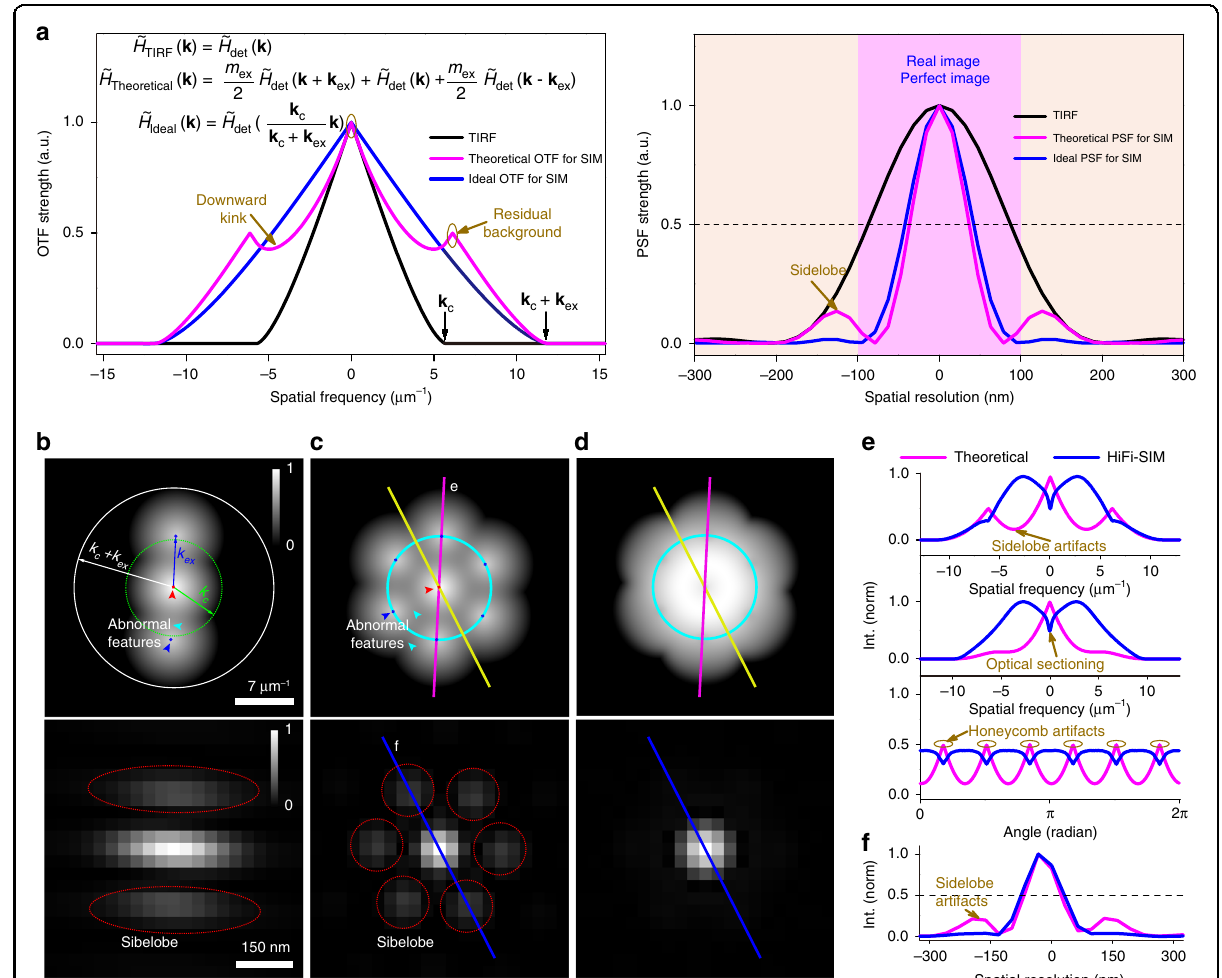
Fig. 1 Underlying principle of PSF engineering. a Theoretical OTFs and corresponding PSFs for wide- fi eld fl uorescence microscopy (total internal re fl ection fl uorescence microscopy, TIRF) and directly combined SR-SIM, and the ideal OTF and corresponding PSF for SR-SIM. The downward kinks in the OTF of directly combined SR-SIM result in sidelobes in PSF, while background fl uorescence signals located at the upward peaks of the OTF cause honeycomb artifacts and limit the OS capability. ~ H det k ð Þ represents the actual OTF for wide- fi eld imaging. k c represents the cut-off frequency of wide- fi eld imaging. m ex and k ex represent the modulation depth and spatial frequency of the excitation pattern, respectively. b 2D OTF and corresponding PSF of directly combined SR-SIM with excitation pattern in only one orientation. c 2D OTF and corresponding PSF of directly combined SR-SIM with excitation patterns in three orientations. Green and white circles represent the diffraction limited boundaries of the wide- fi eld and SR-SIM, respectively; blue spots represent the spatial frequencies of the excitation pattern at different orientations; cyan circles represent the circular cross- section with a radius equal to the spatial frequency of the excitation patterns. d Equivalent OTF and corresponding PSF after optimizing the directly combined OTF by HiFi-SIM. e Intensity pro fi les along the magenta, yellow, and cyan lines in c and d . f Intensity pro fi les along the blue lines in c